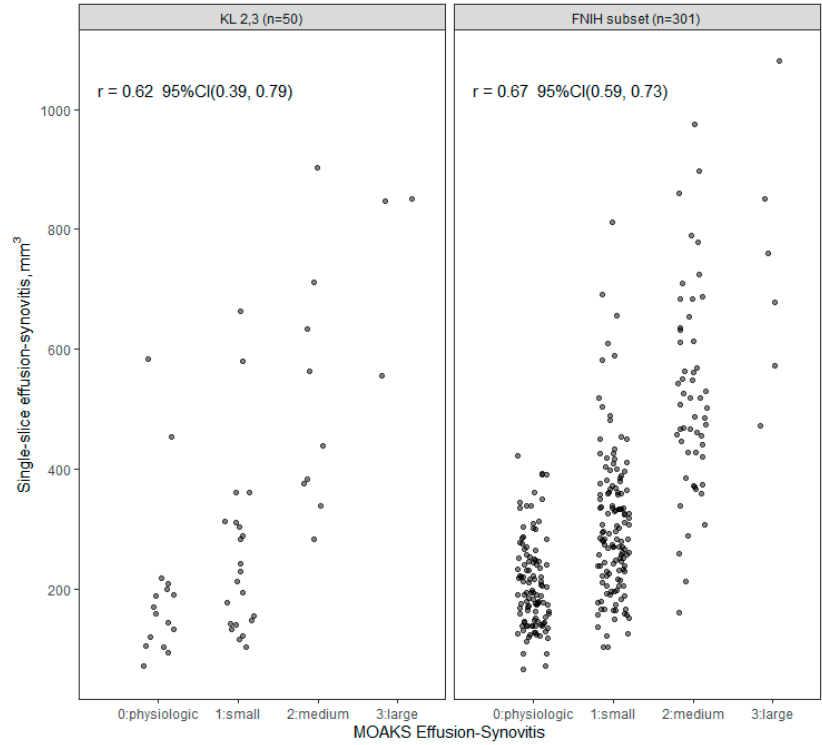
Figure 4. Single-slice vs. multi-slice e ff usion-synovitis volume (FNIH, n = 301).